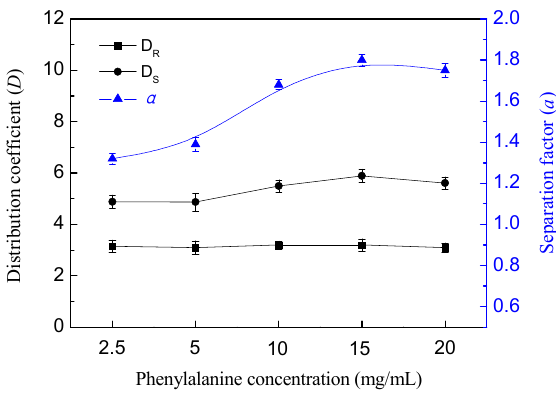
Figure 6. Effect of phenylalanine concentration on the chiral extraction of phenylalanine enantiomers. The extraction conditions were as follows: 30 wt% [Ch][L-Pro], 7.8wt% K 3 PO 4 , 40 mmol/L HP- β -CD. The extraction experiments were done at room temperature and without adjusting the system pH.